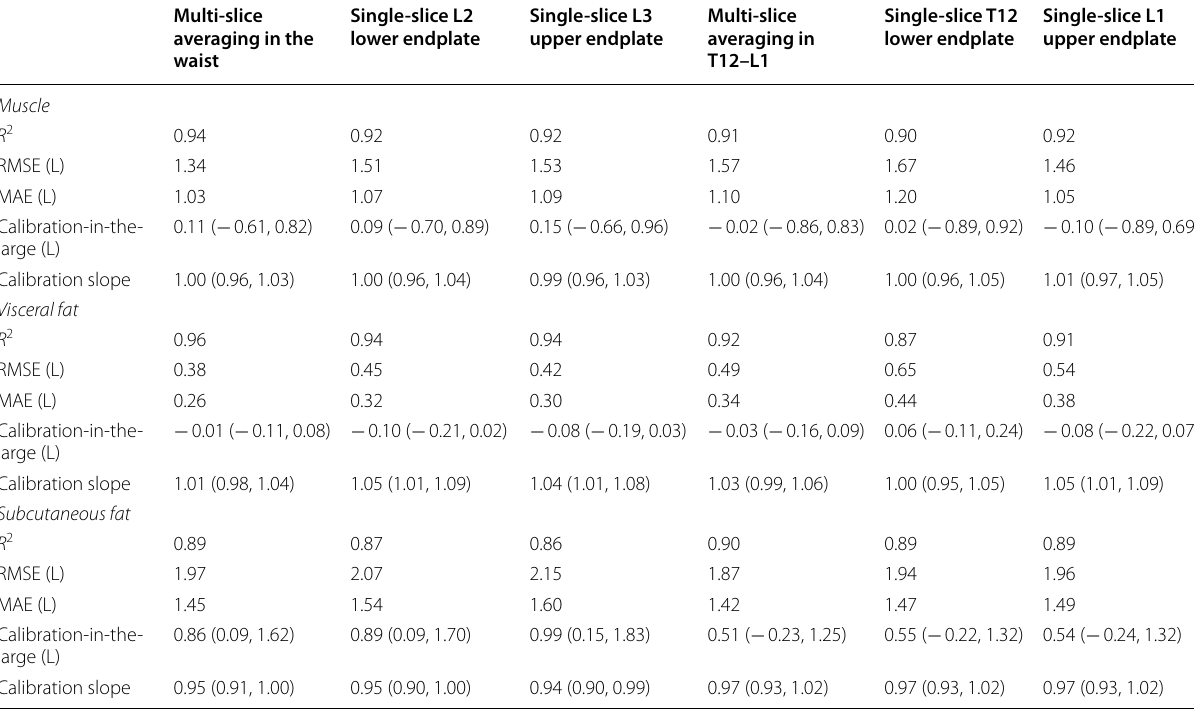
RMSE Root-mean-squared error, MAE Mean absolute error Data in parentheses indicate 95% confidence intervals